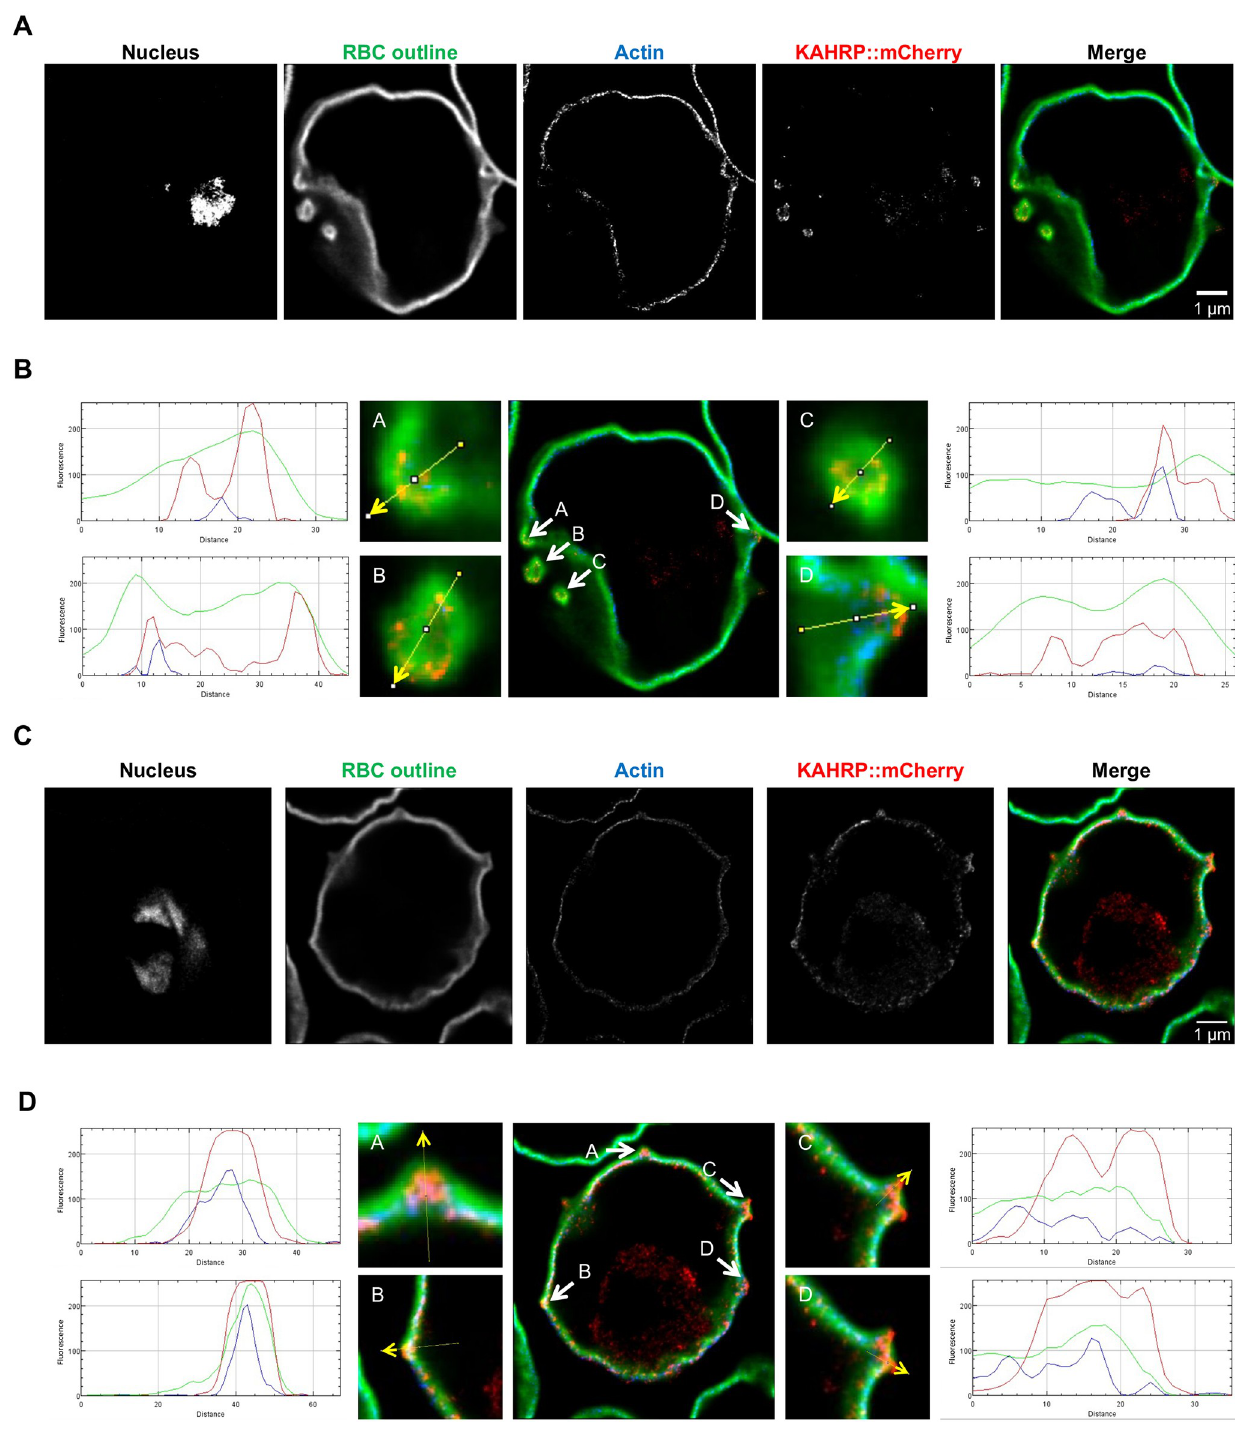
Fig 4. Investigation of the subcellular composition of deformed knobs in Δ PFA [KAHRP :: mCherry] via rSTED imaging in an IFA assay. A, C) DNA was stained using DAPI; WGA was used to stain the RBC glycocalyx; phalloidin was used to stain actin; and RFP booster was used to label KAHRP:: mCherry. B, D) Line scan profiles of fluorescence intensity (arbitrary units) along the yellow arrows shown in the fluorescent overlay. The arrows bisect KAHRP_mCherry-rich structures (likely representing knobs). These profiles demonstrate that in the vertical view, phalloidin ( i . e ., actin) is localised toward the cytosol from the KAHRP structures. The horizontal view shows that the KAHRP-containing structures form a ring structure. These might contain low amounts of actin but are likely filled with other material(s).